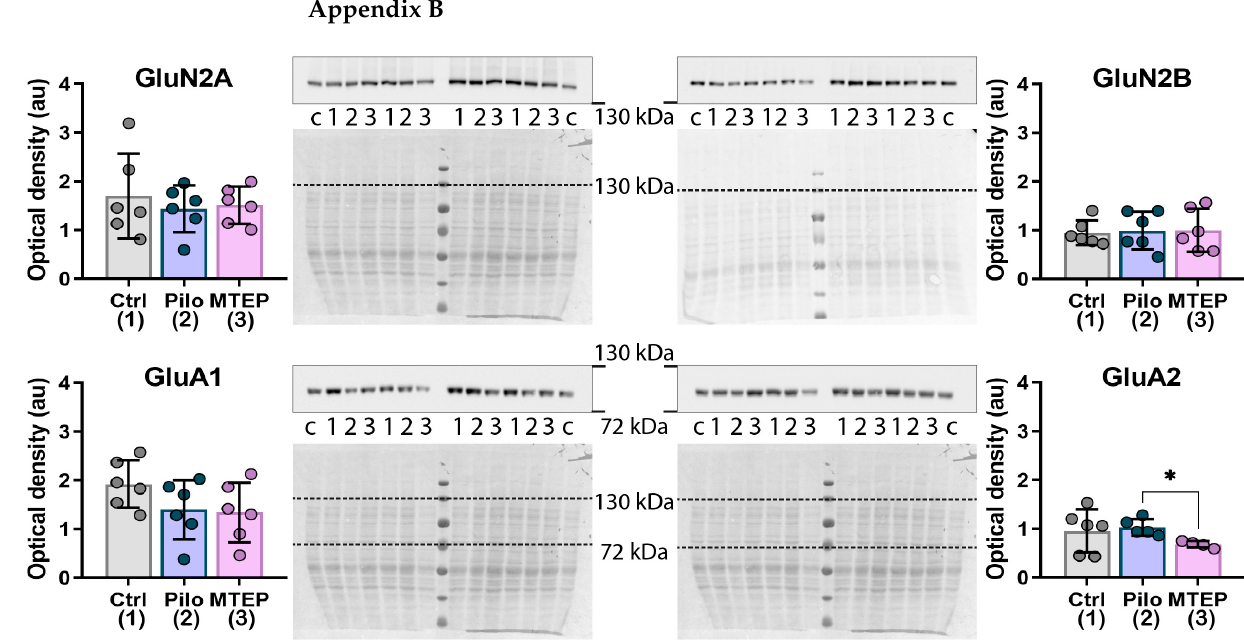
Figure A1. Western blotting data of proteins production in the dorsal hippocampus in chronic phase. For inserts, the upper part shows the chemiluminescent signal and the lower part shows the Ponceau S. For bands, c is calibrator sample, 1 is Ctrl, 2 is Pilo, and 3 is MTEP group. On charts, each dot represents one animal; the columns indicate average values, and error bars show standard deviations. One-way ANOVA, GluN2A: F 2,17 = 0.3, p = 0.75; GluN2B: F 2,17 = 0.3, p = 0.99; GluA1: F 2,16 = 1.9, p = 0.19, GluA2: F 2,7 . 1 = 8.7, p = 0.012. Asterisks indicate significant differences between groups according to Games–Howell post hoc tests: * p < 0.05.